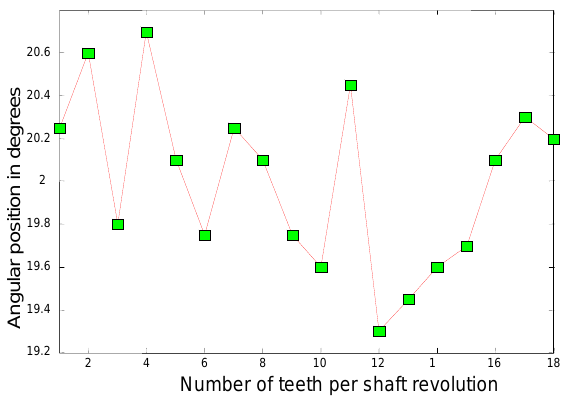
Figure 4. Angular delta shaft position vector corresponding with unique set of compensation factors.